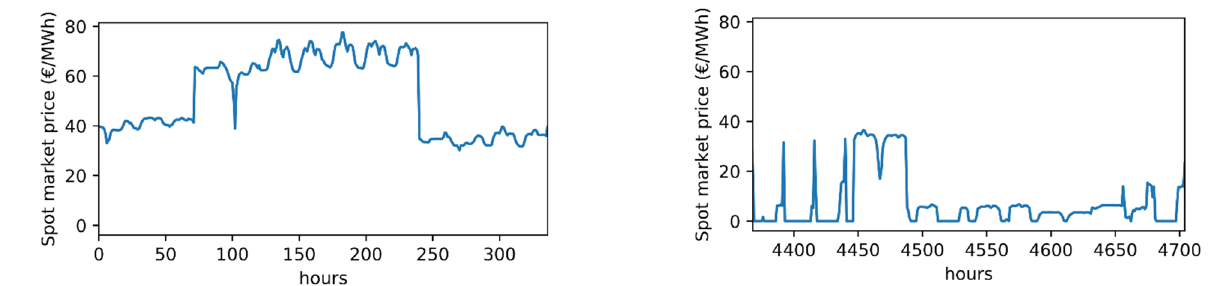
Figure 8. Electricity price profiles for representative weeks for dry season ( left ) and wet season ( right ).